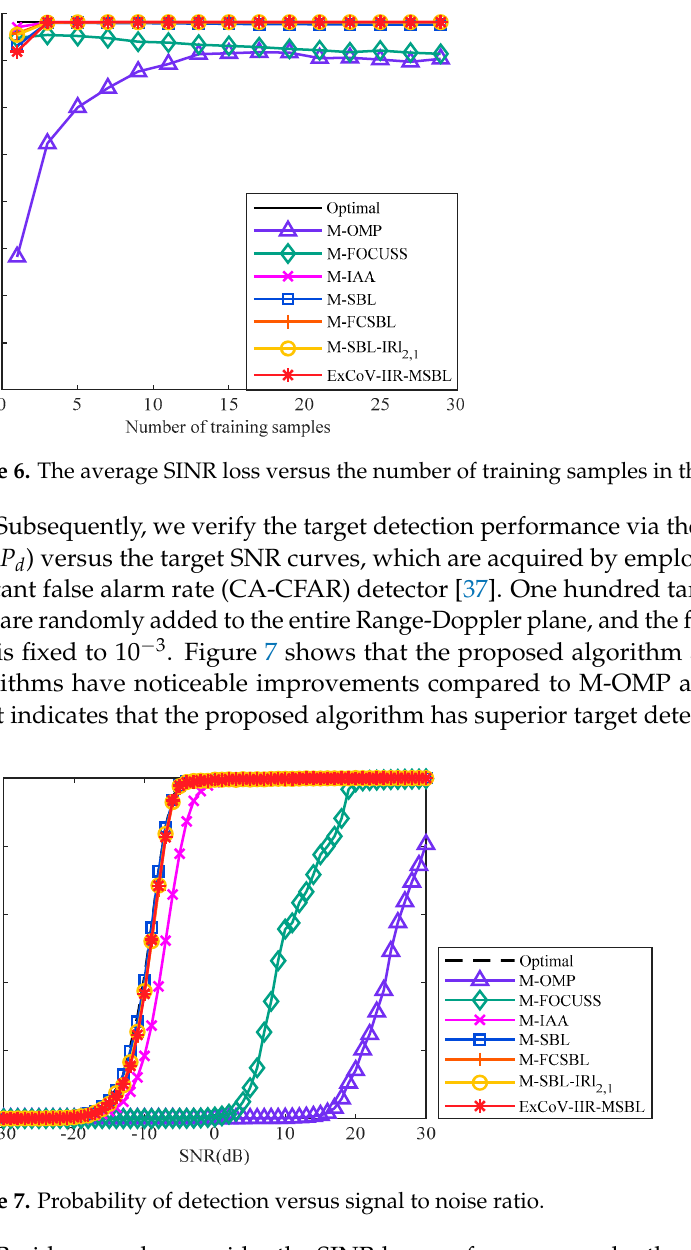
Figure 5. Spatial-temporal responses. ( a ) M-CVX; ( b ) M-OMP; ( c ) M-FOCUSS; ( d ) M-IAA; ( e ) M-  SBL; ( f ) M-FCSBL; ( g ) M-SBL-IR 2,1 ; ( h ) Proposed algorithm.